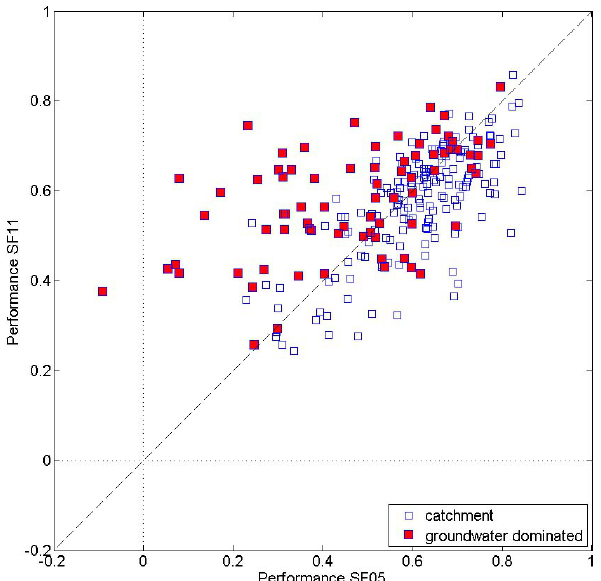
Fig. 5. Average performance of model structure SF05 (without par- allel slow reservoir) against SF11 (with parallel slow reservoir). Groundwater-dominated catchments are marked in red.